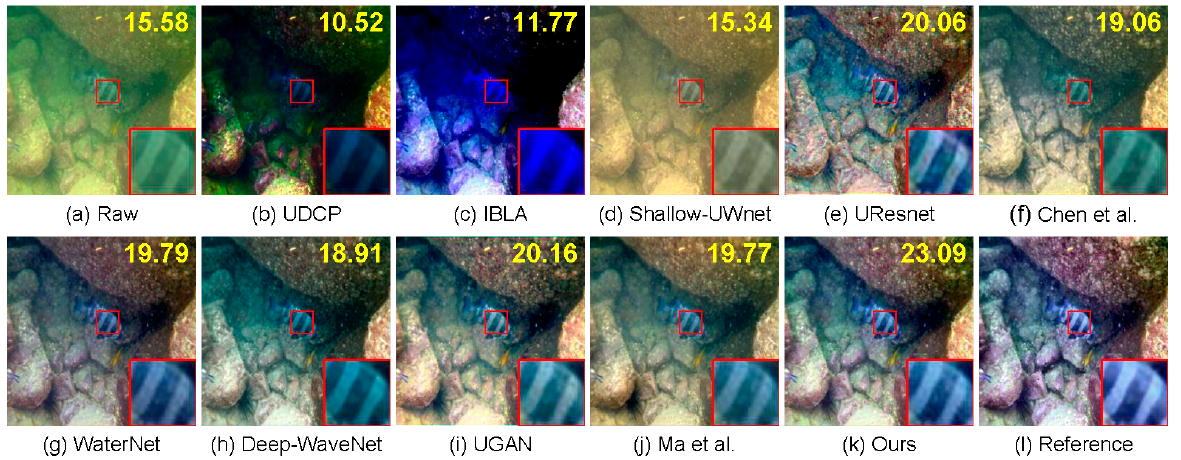
Figure 9. The visual comparisons of various UIE approaches on the yellowish underwater images. The number on each image represents its PSNR score.